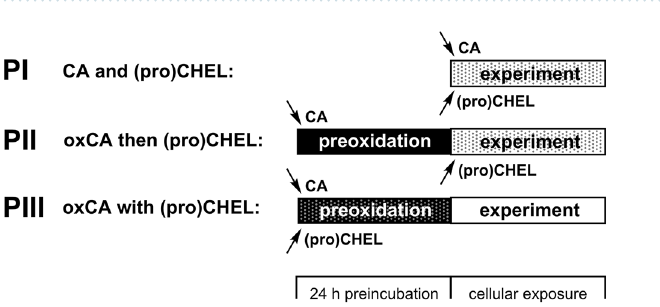
Figure 1. Structures of investigated compounds. Fe chelators used in clinical practice: desferrioxamine (DFO), deferiprone (L1) and deferasirox (ICL670A); catecholamines: 5-(2-aminoethyl)benzene-1,2,4-triol (6-hydroxydopamine) and 4-(2-aminoethyl)benzene-1,2-diol (dopamine); Fe prochelator: ( E )-N ′ -(2-(4,4,5,5- tetramethyl-[1,3,2]dioxaborolan-2-yl)-benzylidene) isonicotinohydrazide (BSIH); Fe chelator: ( E )-N ′ -(2- hydroxybenzylidene) isonicotinohydrazide (SIH) and its complex with Fe [Fe(SIH) 2 ].